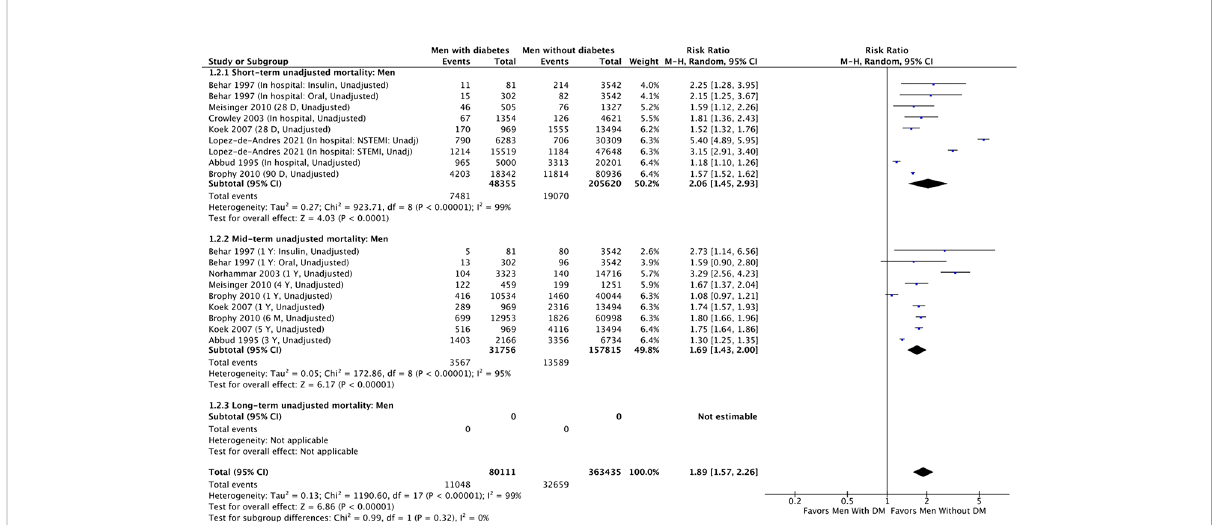
FIGURE 2 Summary of unadjusted short-term, mid-term and long-term risk estimates for post-AMI all-cause mortality in men with diabetes compared to men without diabetes. (Data extracted from 8 studies and including of total of 80,111 men with diabetes and 363, 435 men without